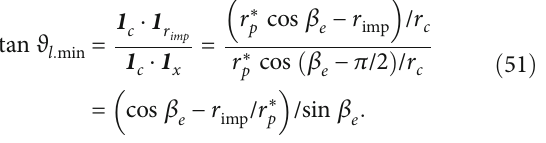
Table 1: Parameter deviation and uncertainty